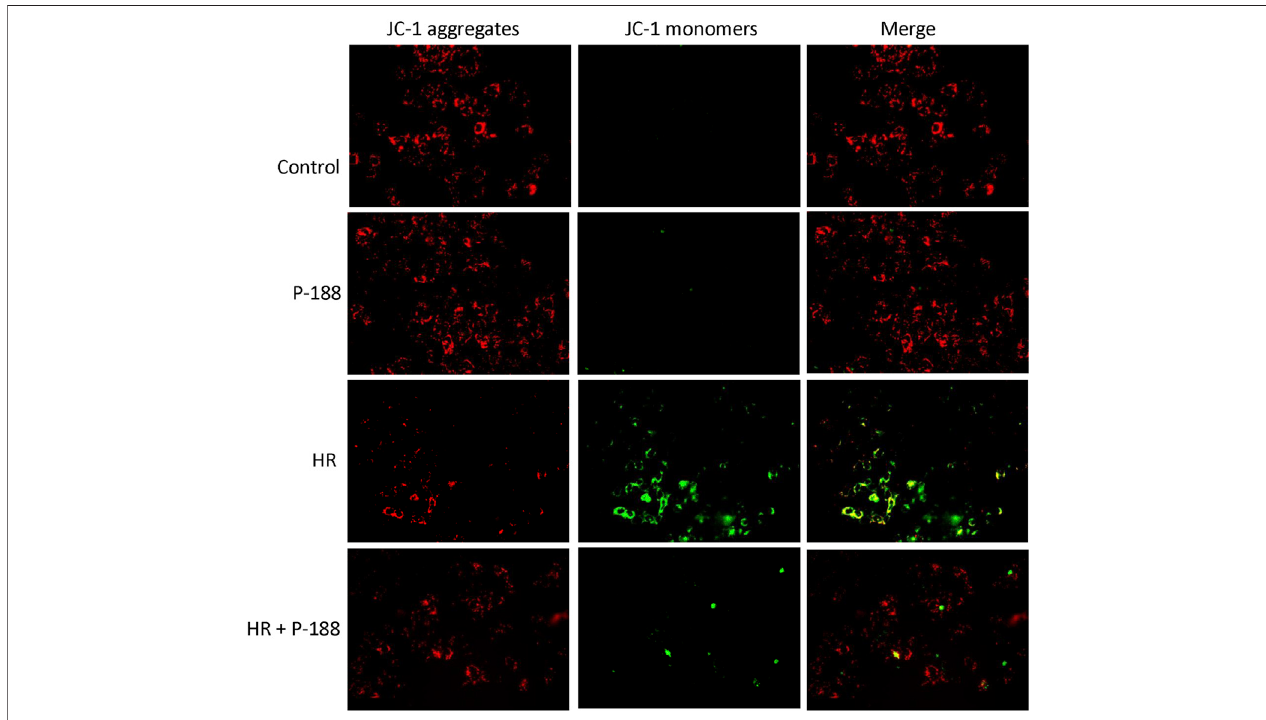
FIGURE 7 | Effect of P188 on depolarization of mitochondrial membrane potential in MLE-12 cells exposed to hypoxia/reoxygenation (HR). Red JC-1 dimers indicate normal mitochondrial membrane potential. Green JC-1 monomers re fl ect depolarization of mitochondrial membrane potential. The red dimers and green monomers co-localized. Experiments were repeated three times